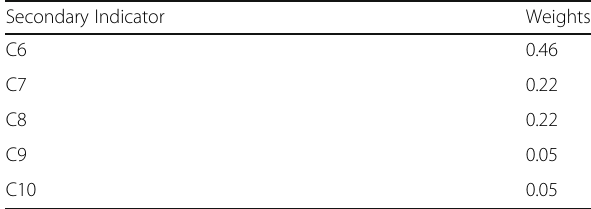
Table 10 Weight of secondary indicators under “ Freight Competitiveness ” . (Source: Authors)